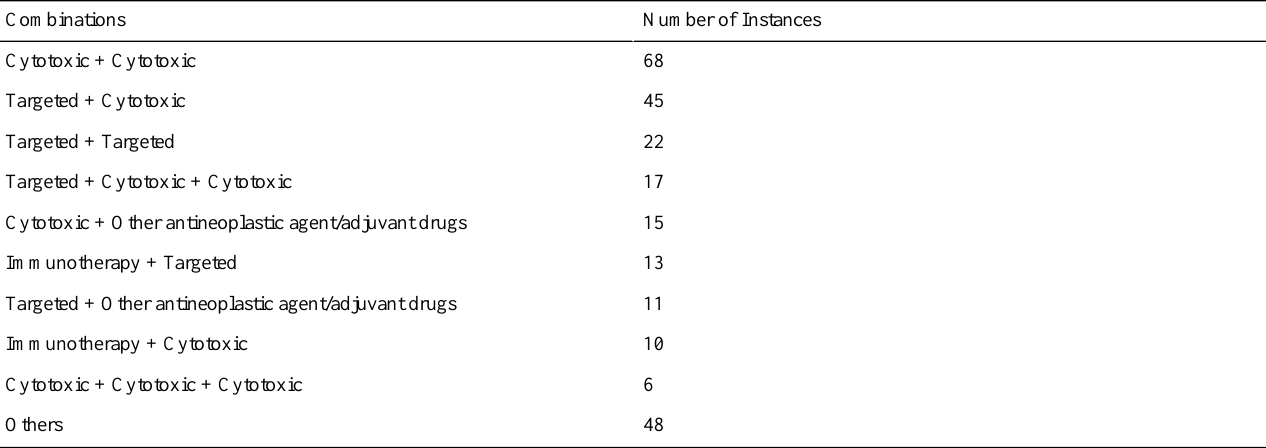
Table 4. Major patterns of combined medication based on mechanisms of antineoplastic agents.